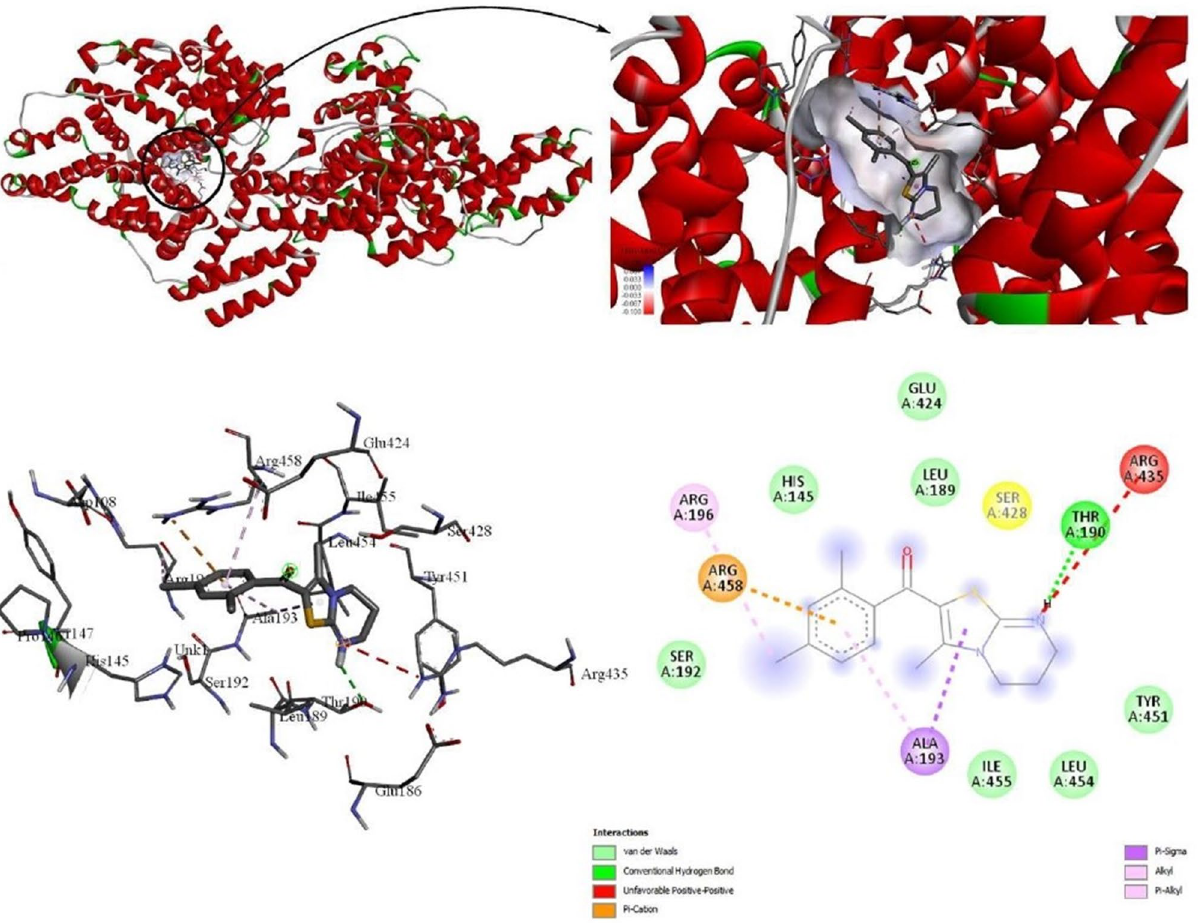
Figure 7. A 2D/3D plots of 4g interacted in the subdomain of chain A of BSA. The figure was generated using BIOVIA Discovery Studio Visualizer (DSV) (https:// disco ver. 3ds. com/ disco very- studio- visua lizer- downl oad).